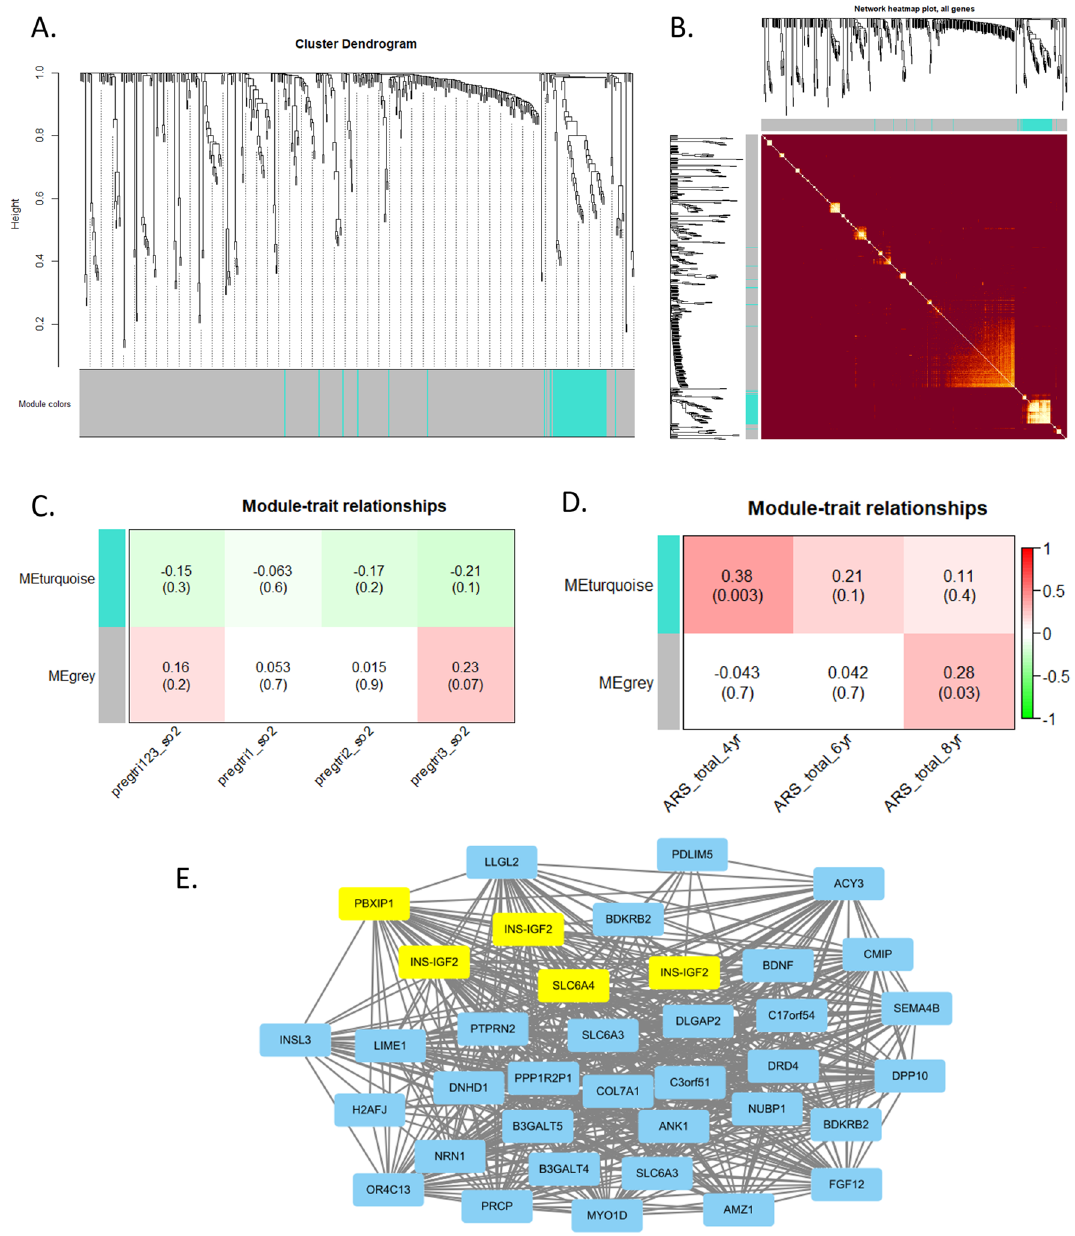
Figure 4. Weighted gene co-methylation network analysis of DNA methylation at CpGs for candidate gene analysis. ( A ) Dendrogram produced by hierarchical chlustering of samples. Modules of co-methylated CpGs are indicated by different color (grey and turquoise) beneath the dendrogram. ( B ) Network heatmap plot. Dendrograms from hierarchical clustering are corresponded to the color-coded modules (grey and turquoise). In the heatmap, bright yellow color indicate high co-expression inter-connectedness. ( C ) Correlating modules with exposure variables (prenatal SO2 exposure by trimester). ( D ) Correlating modules with outcome variable (ADHD rating scales at age 4, 6 and 8). ( E ) Network between CpGs from the turquoise